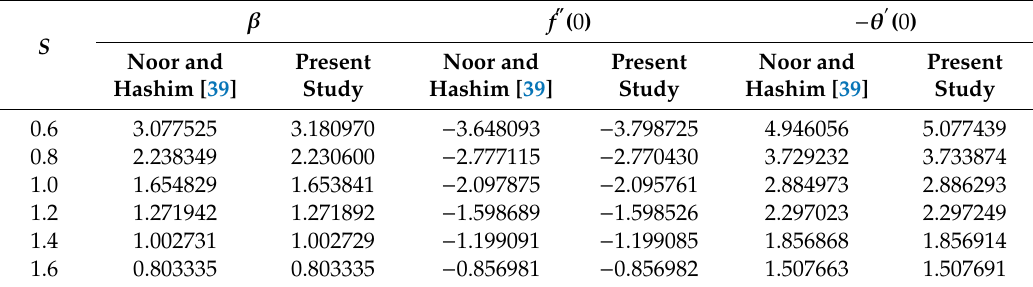
Table 2. Comparison values of β , f (cid:48)(cid:48) ( 0 ) and − θ (cid:48) ( 0 ) when n = 3,Pr = 1, We = S = 0 and M = 1. β f ” ( 0 ) − θ (cid:48) ( 0 ) S Noor and Present Noor and Present Noor and Present Hashim [39] Study Hashim [39] Study Hashim [39]